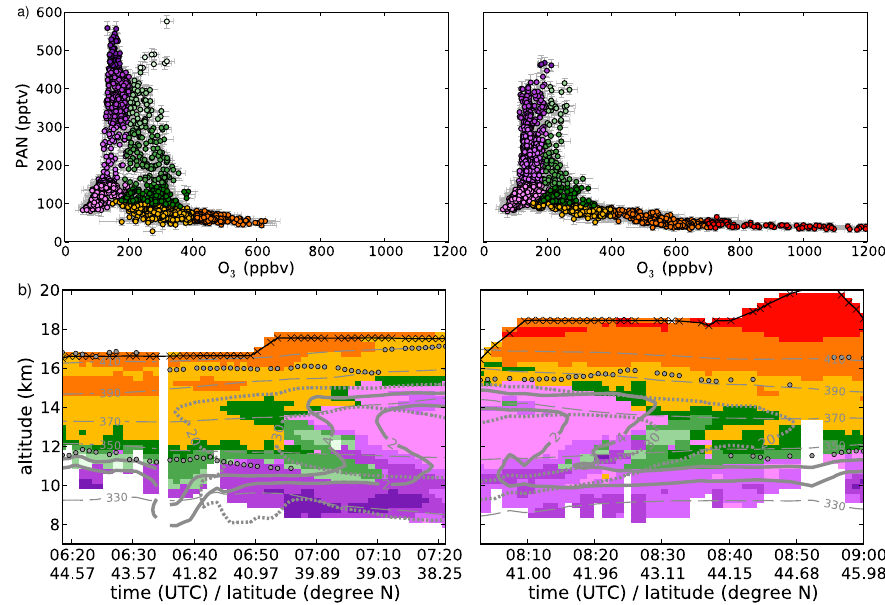
Fig. 10. Relationship between PAN and O 3 . Both panels show the western (left) and eastern (right) cross sections separately. (a) shows the location of air parcels in tracer-tracer space for all measured air parcels including error bars in light grey. Red colours indicate the stratospheric branch, purple colours indicate the tropospheric branch, and green colours indicate air parcels that could not be assigned to either category. Different shades of red are assigned according to O 3 VMR (with thresholds of 400 and 700ppbv). Different shades of green and purple are assigned according to PAN VMR (with thresholds of 150, 300, and 450pptv). (b) shows the geo-spatial distribution of air parcels coloured according to their location in tracer-tracer space, i.e. with the same colours used in (a) .